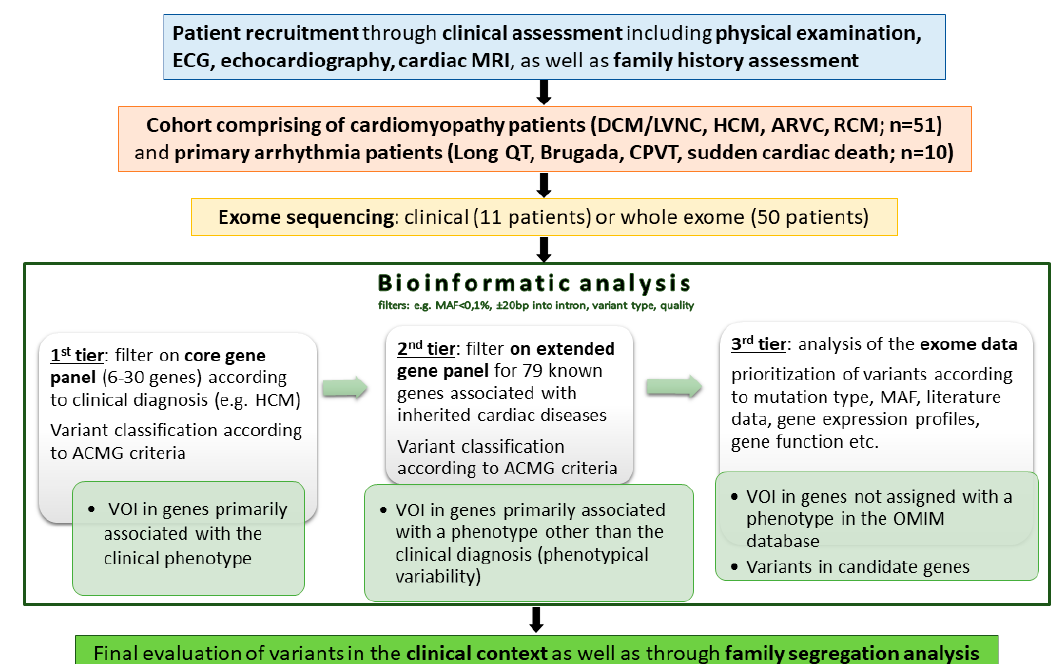
Figure 1. Workflow diagram. (DCM: dilated cardiomyopathy; HCM: hypertrophic cardiomyopathy; RCM: restrictive cardiomyopathy; LVNC: left ventricular noncompaction cardiomyopathy; ARVC: arrhythmogenic right ventricular cardiomyopathy; and CPVT: catecholaminergic polymorphic ventricular tachycardia).